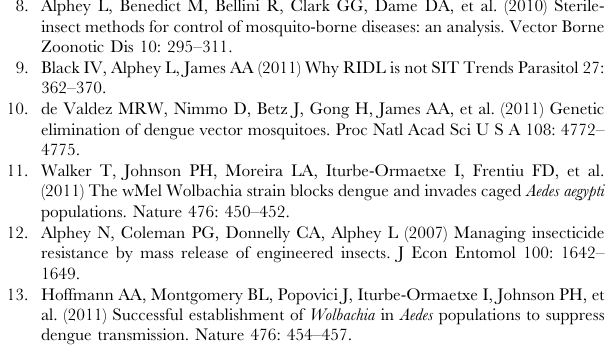
Figure S1 Example of result obtained after migration of one PCR realized with A9 marker on the progeny from two different Aedes albopictus females. (JPG) Figure S2 Example of result obtained after migration of one PCR realized with AEDC marker on two different Aedes albopictus females. (JPG) Figure S3 Example of an electrophoregram obtained after PCR realized with A9 marker on an Aedes albopictus individual. The screenshot from GeneMapper software represents two electro- phoregrams of an heterozygous individual (marker A9; the below image being a zoom of the image above). Figure S4 Example of an electrophoregram obtained after PCR realized with AEDC marker on an Aedes albopictus individual. The screenshot from GeneMapper software represents two electro- phoregrams of an homozygous individual (marker AEDC; the below image being a zoom of the image above). Table S1 Genotyping of Aedes albopictus individuals studied with microsatellite markers A9 and AEDC. The female and offsprings genotypes were observed with the electrophoregram. The male genotype was obtained with Gerud